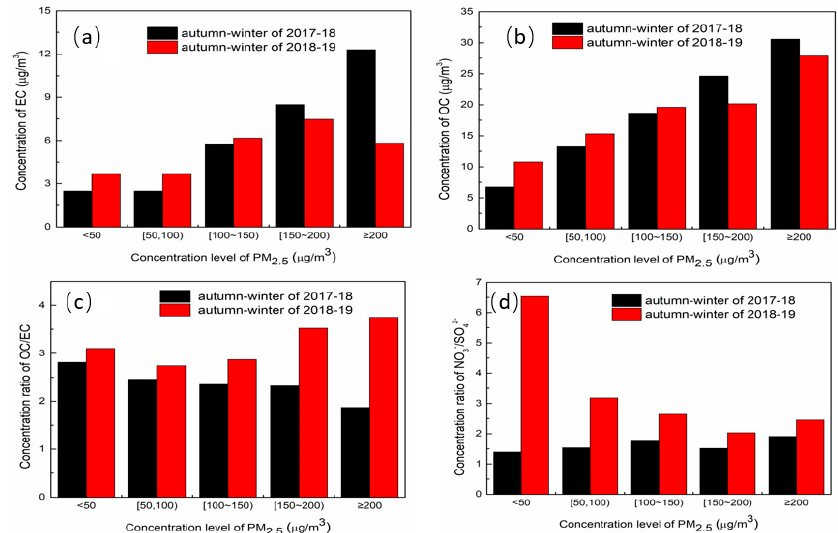
Figure 4. Concentration of EC ( a ), OC ( b ), and concentration ratio of OC/EC ( c ), NO 3 − /SO 4 2 − ( d ) at different concentration levels of PM 2.5 .